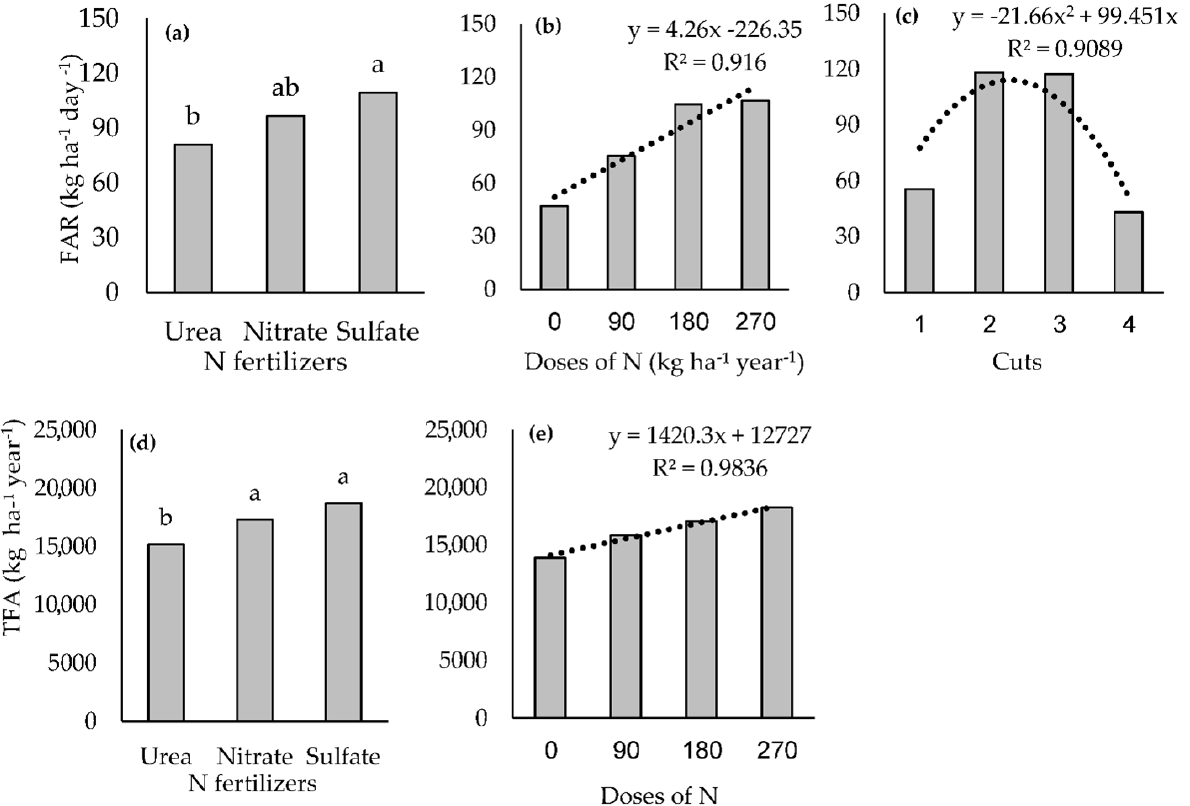
Figure 3. Forage accumulation rate (FAR, kgDM ha − 1 day − 1 ) and total forage accumulation (TFA, kg ha − 1 year − 1 ) of marandu palisade grass pasture in fertilization with N fertilizers and doses. ( a ) effect of N fertilizers on the FAR, ( b ) effect of doses of N on the FAR, ( c ) effect of cuts on the FAR, ( d ) effect of N fertilizers on the total accumulation, ( e ) effect of doses of N on the total accumulation.